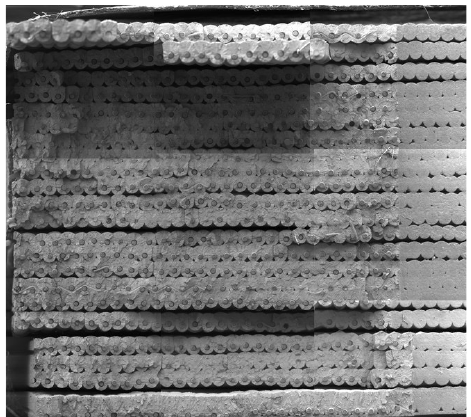
Figure 9. Composite picture of the fracture surface of the large sample with FVF and density as given in Table